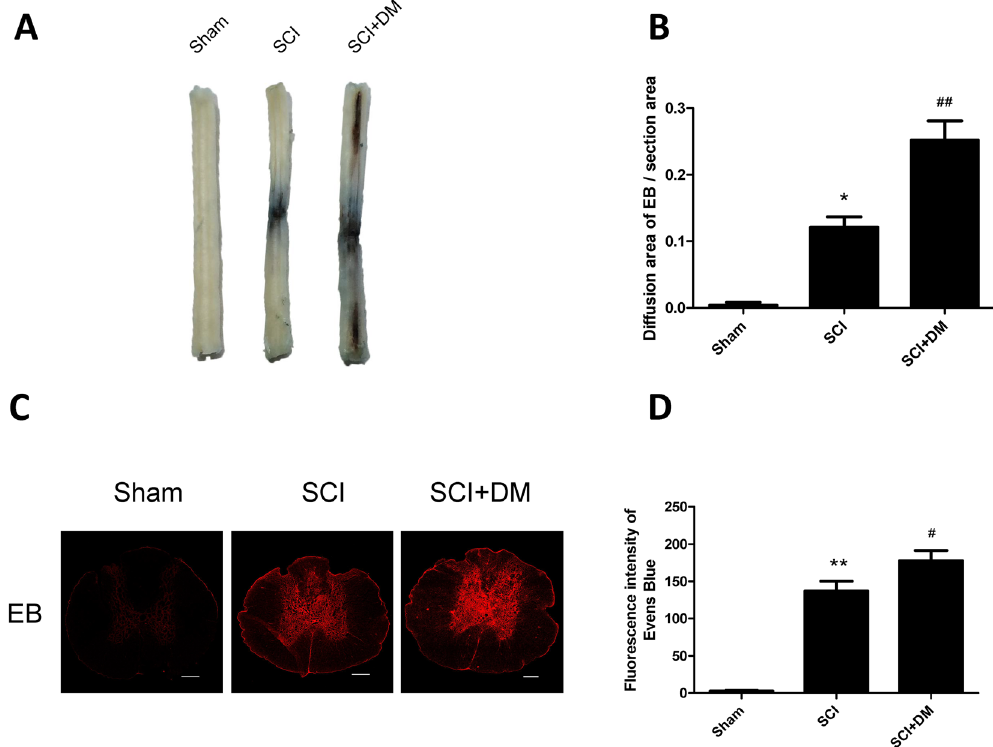
Figure 1. DM aggravates blood–spinal cord barrier (BSCB) permeability after SCI. After SCI, barrier permeability was measured 1d after injury, using Evans Blue (EB) dye in sham, SCI, and SCI + DM group. ( A , B ) Representative whole spinal cords and quantification of BSCB permeability data in each group showing EB dye permeabilized into the spinal cord, n = 4. ( C , D ) Representative confocal images of EB extravasation and quantification of the fluorescence intensity of EB in each group. Scale bar = 1 mm. n = 4, * p < 0.05, ** p < 0.01 vs sham group, # p < 0.05, ## p < 0.01 vs SCI